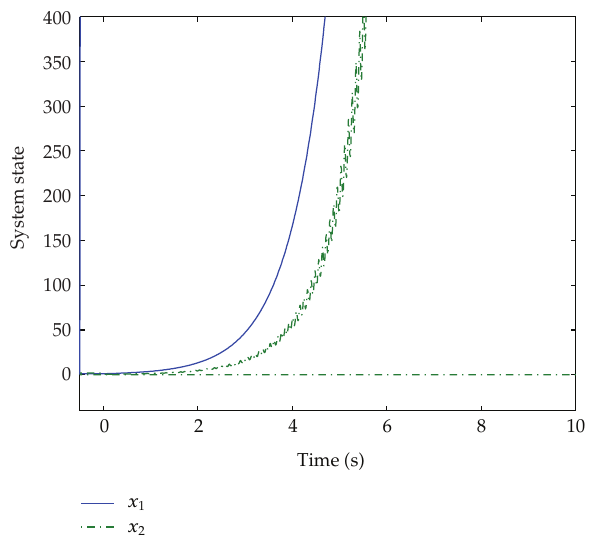
Figure 1: The state trajectories of the open-loop subsystem 1.